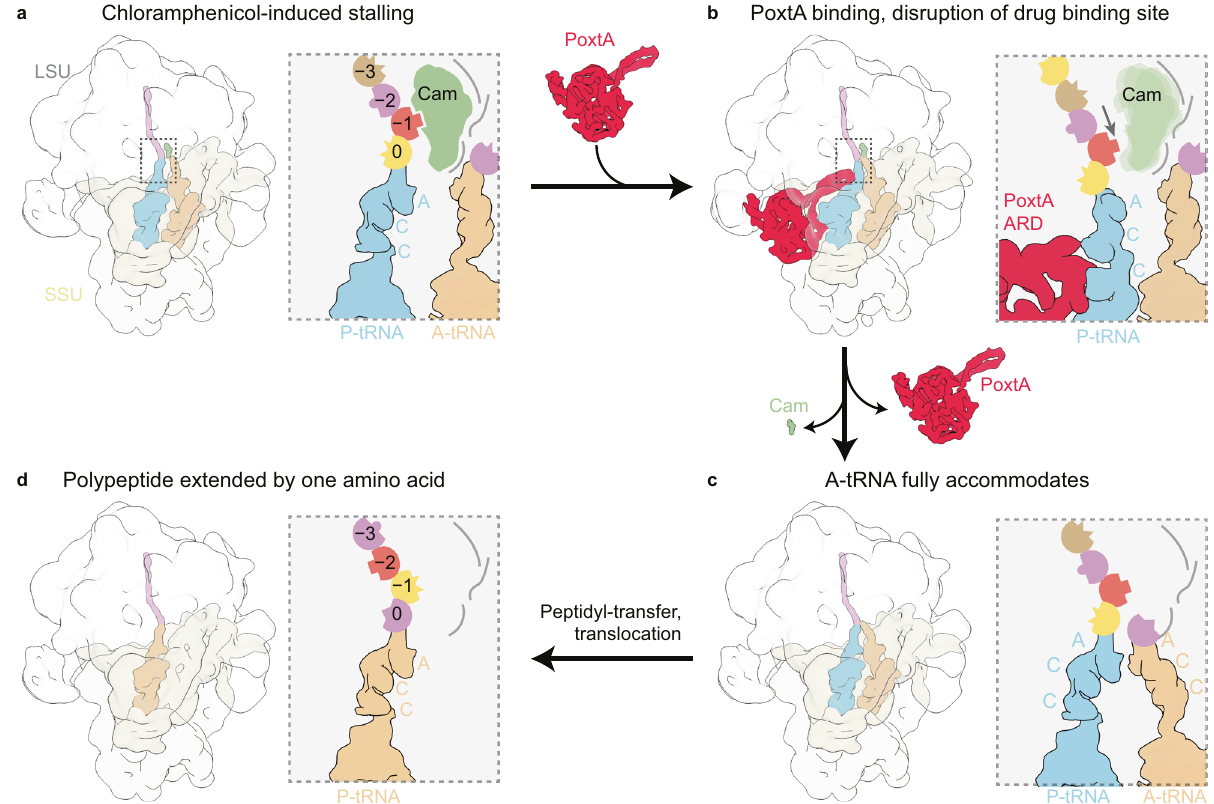
Fig. 6 Model for ribosome protection by PoxtA. a Elongating ribosomes are stalled by PhO antibiotics with a peptidyl-tRNA in the P-site. The sidechain of the amino acid at position − 1 contributes to the PhO-binding site. b Stalled ribosomes are recognised by PoxtA, which induces a shifted P-site tRNA and nascent chain, thereby disrupting the PhO-binding site. c After dissociation of the PhO drug and PoxtA, the P-tRNA and nascent chain return to the regular conformation. Accommodation of an A-tRNA occludes the drug-binding site. d After peptidyl transfer and translocation, amino acid at position − 1 would change, thereby resetting the PhO-binding